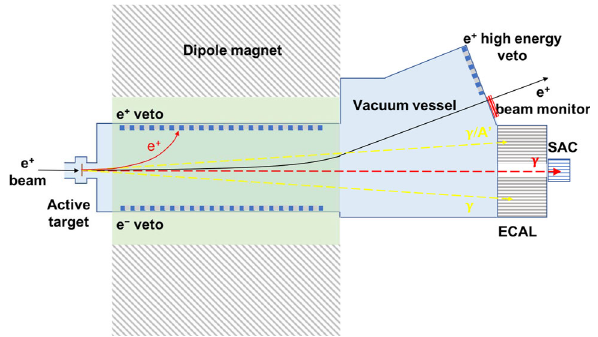
Fig. 52 A layout of the PADME detector